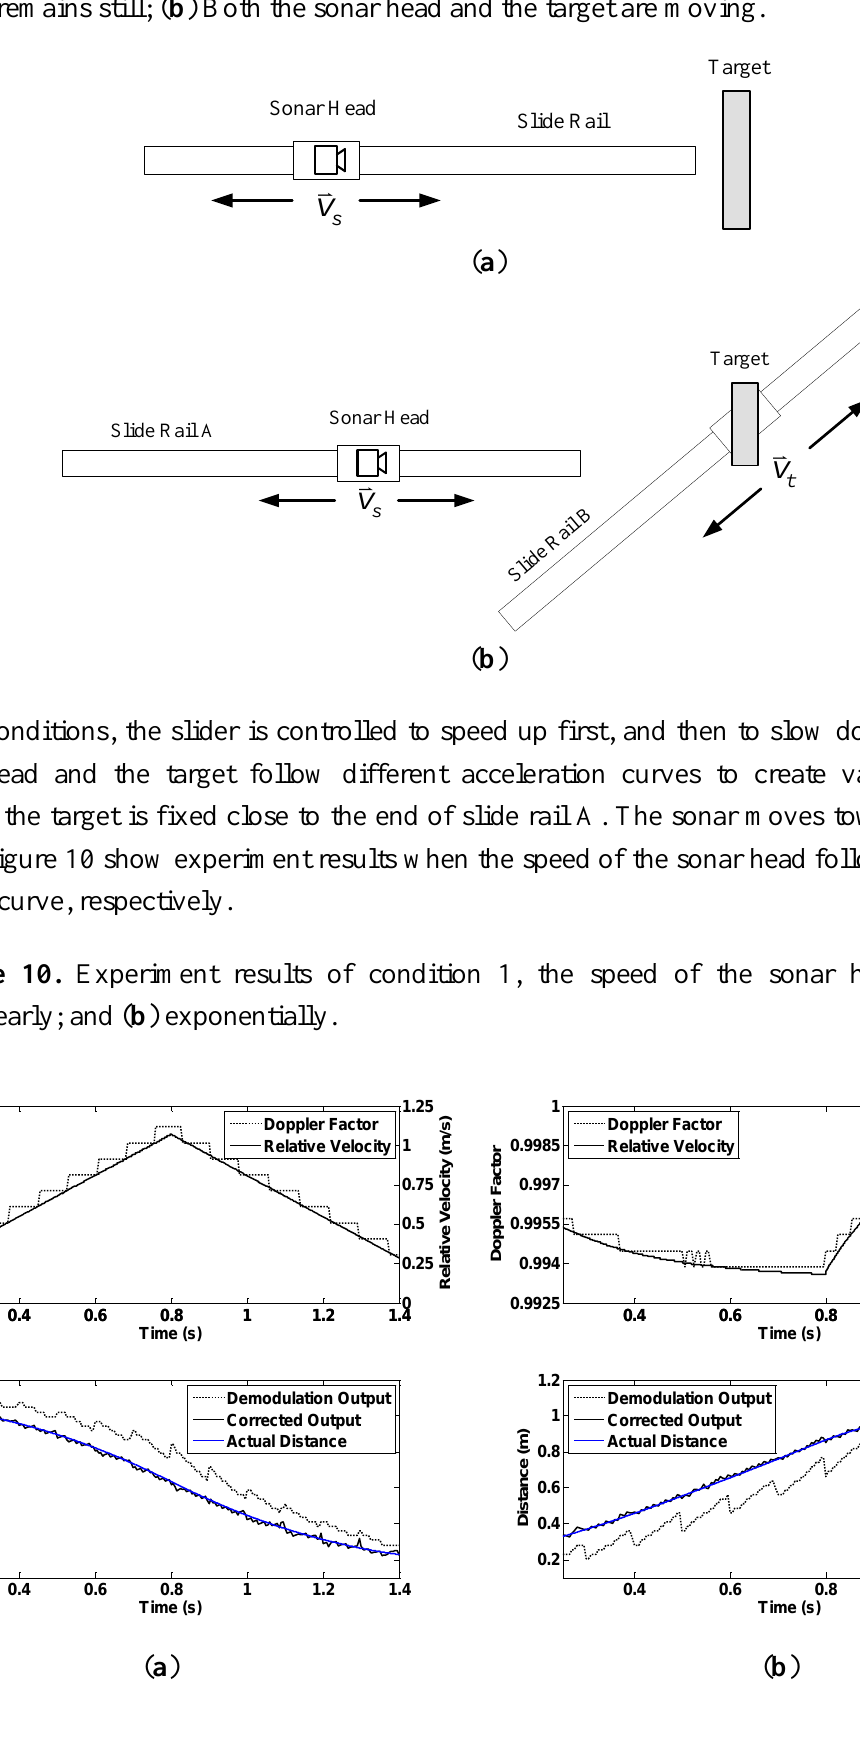
Figure 9. The setup for the two tested conditions. ( a ) The sonar head is moving while the target remains still; ( b ) Both the sonar head and the target are moving.